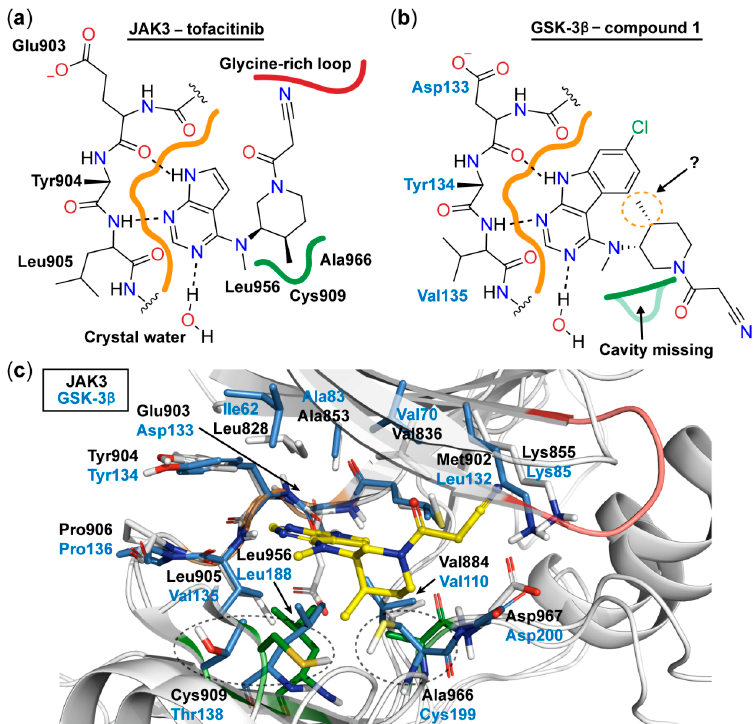
Figure 1. Schematic 2D representation of the binding mode of tofacitinib to JAK3 derived from its co-crystal structure (PDB ID: 3LXK) [16] ( a ) and the expected binding mode of 1 to GSK-3 β ( b ). The lipophilic cavity is highlighted with green and the hinge region with orange. Hydrogen bonds are depicted as dashed lines. ( c ) 3D superposition based on the hinge regions of GSK-3 β (PDB ID: 4PTC) and JAK3 (PDB ID: 3LXK) shows a high conservation of the residues in the ATP binding site [17]. The lipophilic cavity is missing in GSK-3 β , as the spatial orientation of the Thr138 is totally different compared to the Cys909 in JAK3 and the residue Cys199 is bulkier than the Ala966 found in JAK3. Moreover, this Cys199 would clash with tofacitinib (yellow) in its JAK3 binding conformation. Residues near to tofacitinib are depicted as sticks. The stick coloring is the following: GSK-3 β , blue; JAK3, grey; JAK3 residues forming the lipophilic cavity, green. The cartoon coloring is the following: hinge regions, orange; lipophilic cavity residues, green; JAK3 glycine-rich loop, red.